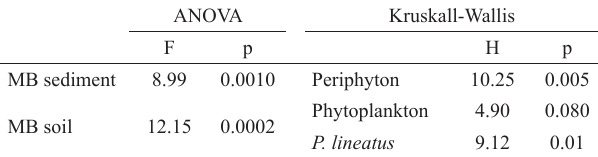
Tab. 2. The values of results of ANOVA and Kruskal-Wallis tests from carbon sources for P. lineatus in the area studied (MB: Microbial Biomass).